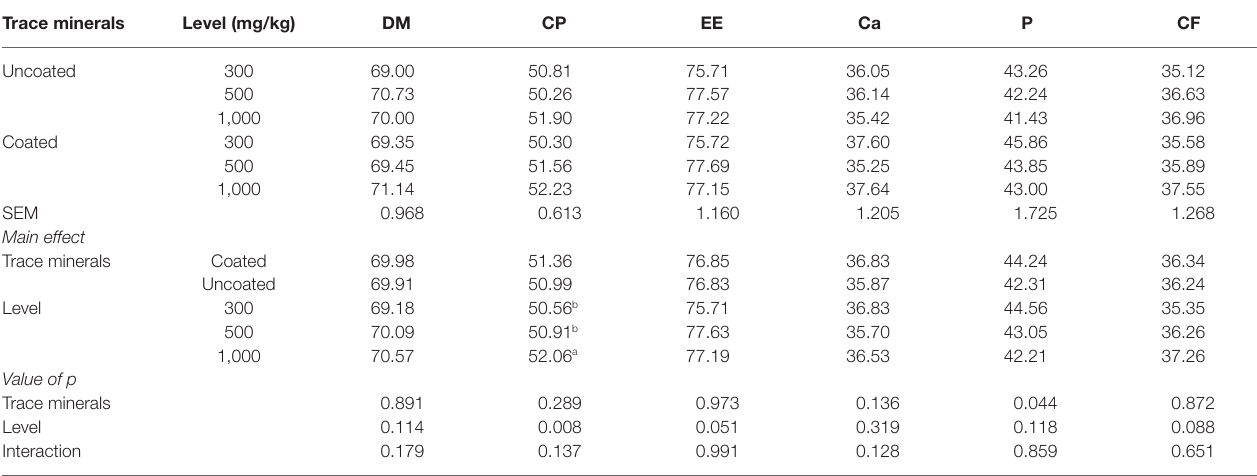
TABLE 3 | Effects of trace mineral type (coated or uncoated) and supplementation level (300, 500, or 1,000 mg/kg) of trace minerals on the total tract nutrient digestibility of ducks. Trace minerals